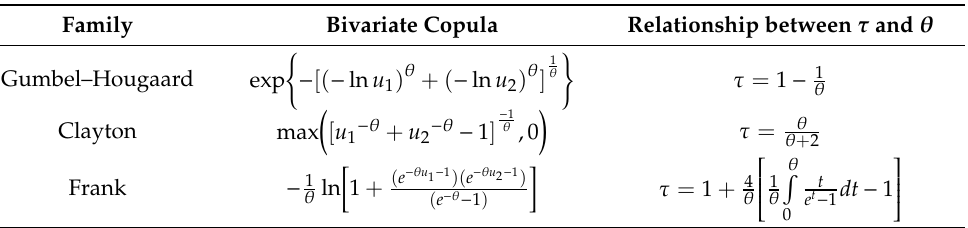
Table 1. Archimedean copulas: families of tested functions (left column), functions of each family (central column) and relationship equations between τ and θ (right